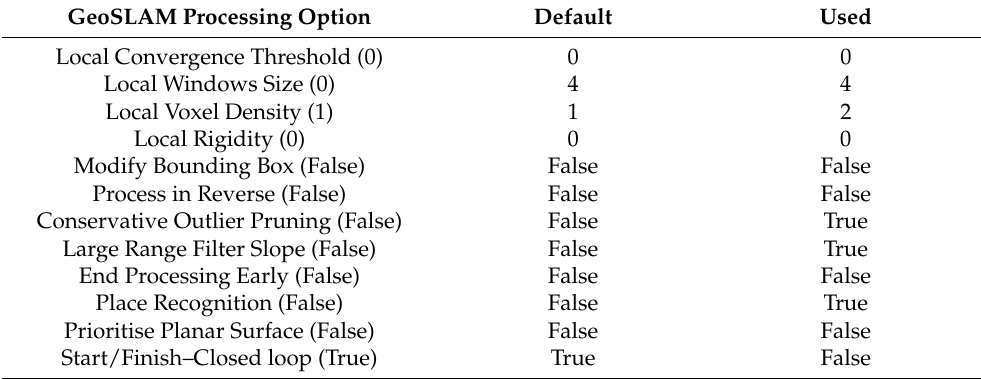
Table A1. Processing options used in GeoSLAM V 4.1.1 to give best results in gullied environment.